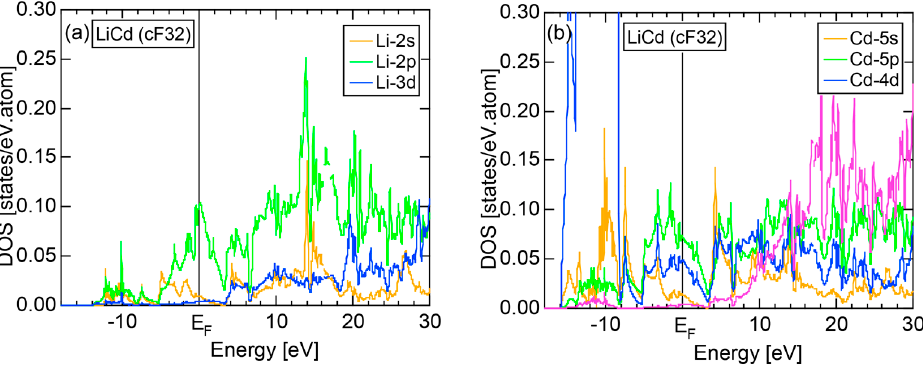
Figure 64. ( a ) Li- and ( b ) Cd-pDOSs for LiCd (cF32) [11,41].